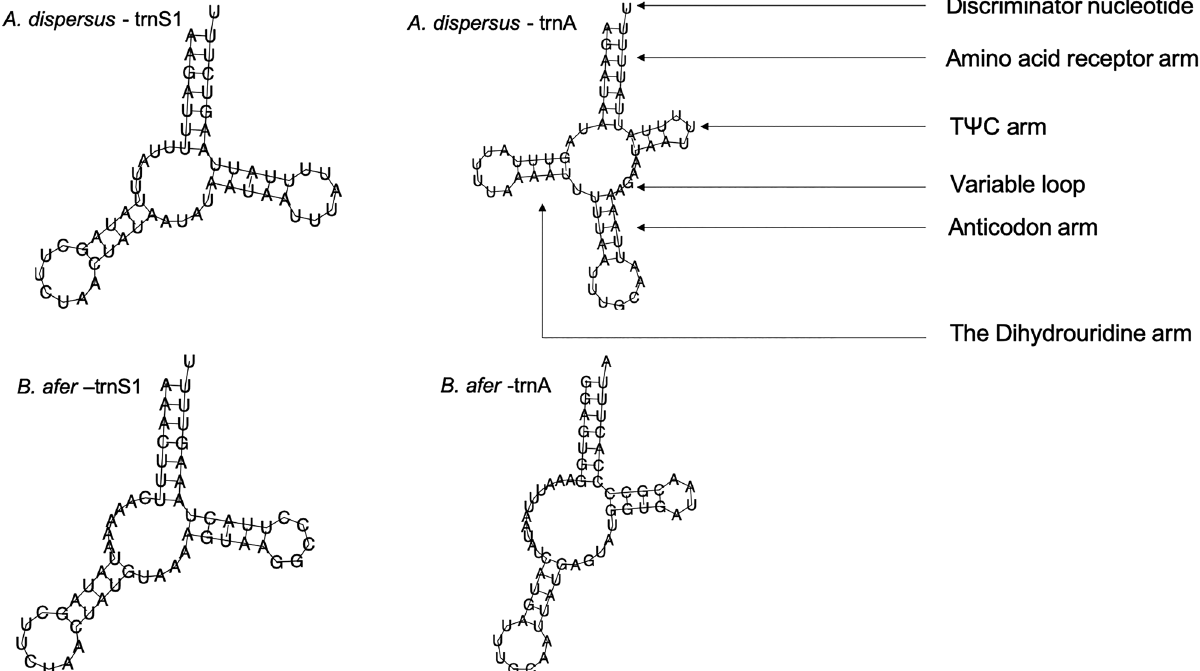
Figure 5. Transfer RNA secondary structure of trnA and trnS1 in Aleurodicus dispersus and Bemisia afer as predicted by MITOS showing presence and absence of dihydrouridine